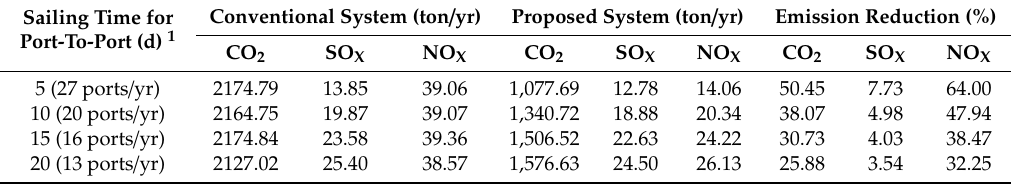
Table 17. Comparison of emissions according to di ff erent sailing times.